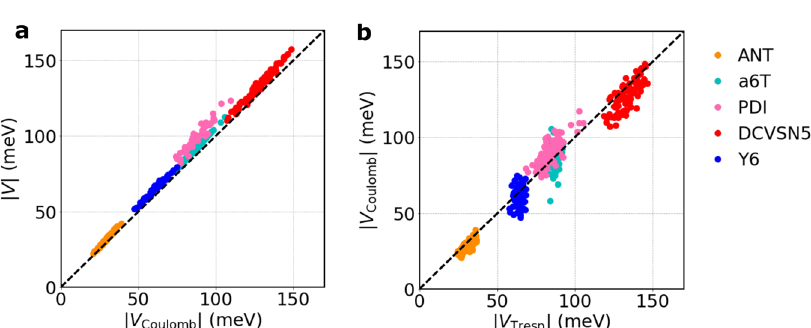
(Fig. 4b, section shaded in yellow). Averaging over all trajectories,